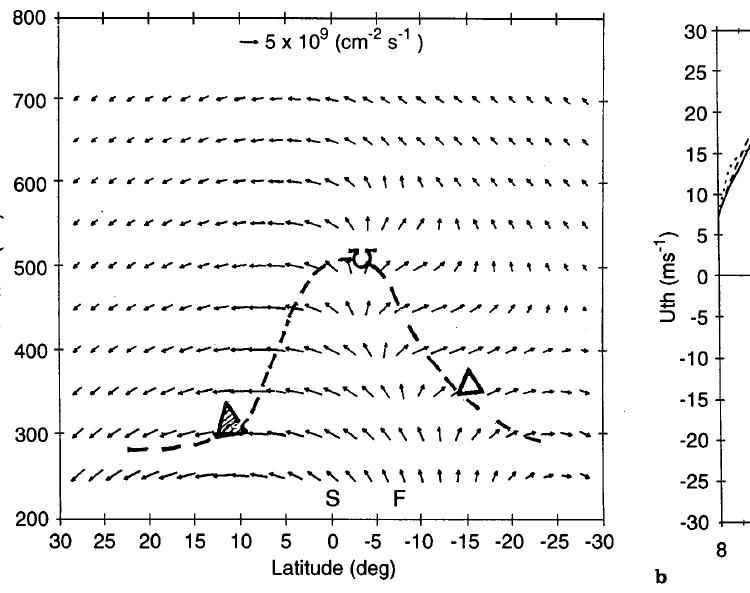
(Solar flux minimum). The curve used for the present SUPIM simulation is the Summer case (solid